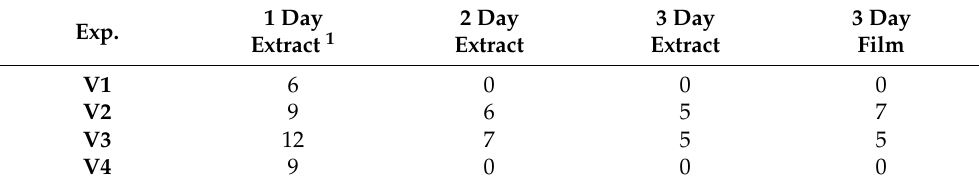
Table 5. Inhibition of St. aureus by V1 – V4 film extracts (by diameter of transparent area, mm).